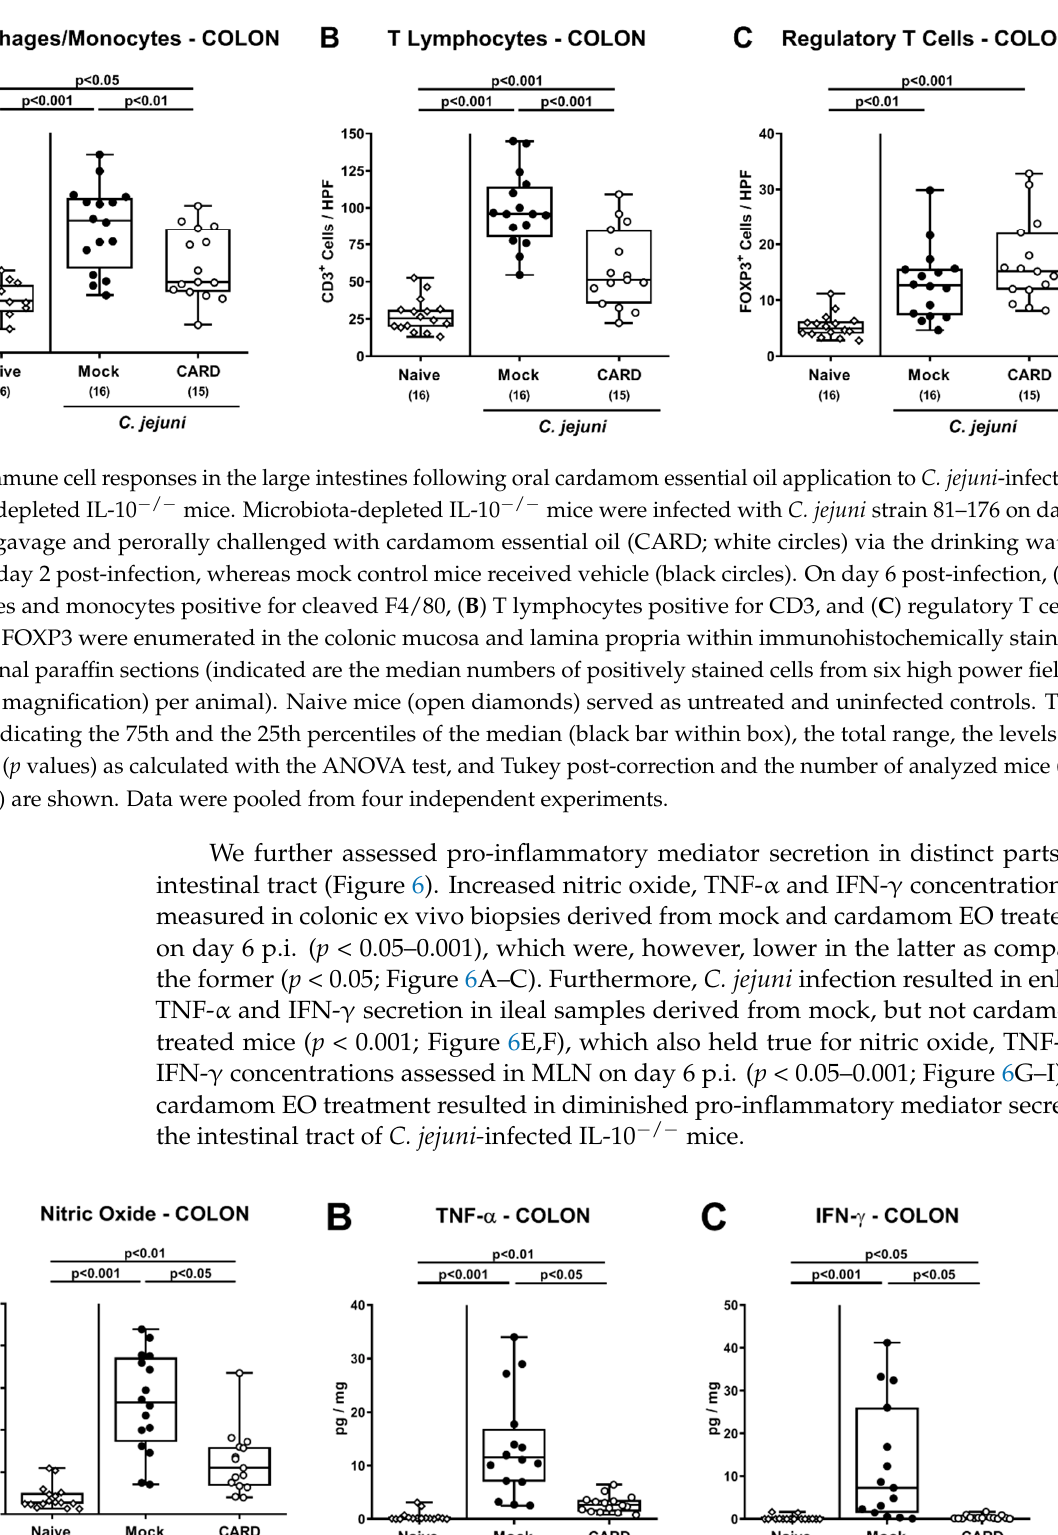
Figure 6. Intestinal pro-inflammatory mediator secretion following oral cardamom essential oil application to C. jejuni - infected microbiota-depleted IL-10 -/- mice. Microbiota-depleted IL-10 -/- mice were infected with C. jejuni strain 81–176 on days 0 and 1 by gavage and perorally challenged with cardamom essential oil (CARD; white circles) via the drinking water starting on day 2 post-infection, whereas mock control mice received vehicle (black circles). On day 6 post-infection, ( A , D , G ) nitric oxide, ( B , E , H ) TNF- α , and ( C , F , I ) IFN- γ concentrations were measured in ex vivo biopsies derived from the ( A – C ) colon, ( D – F ) ileum, and ( G – I ) mesenteric lymph nodes (MLN). Naive mice (open diamonds) served as untreated and uninfected controls. The box plots indicating the 75th and the 25th percentiles of the median (black bar within box), the total range, the levels of significance ( p values) as calculated with the Kruskal–Wallis test and Dunn’s post-correction, and the number of analyzed mice (in parentheses) are shown. Data were pooled from four independent experiments.